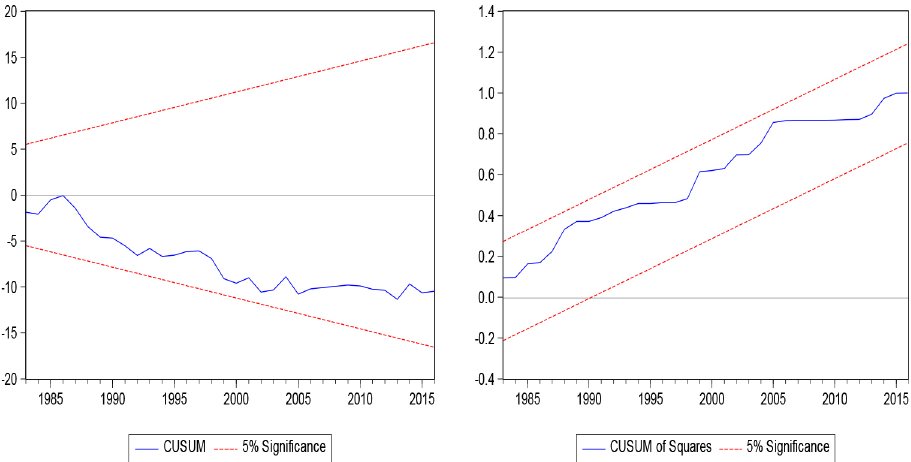
Fig. 4. Cusum and Cusumsq plots for Model